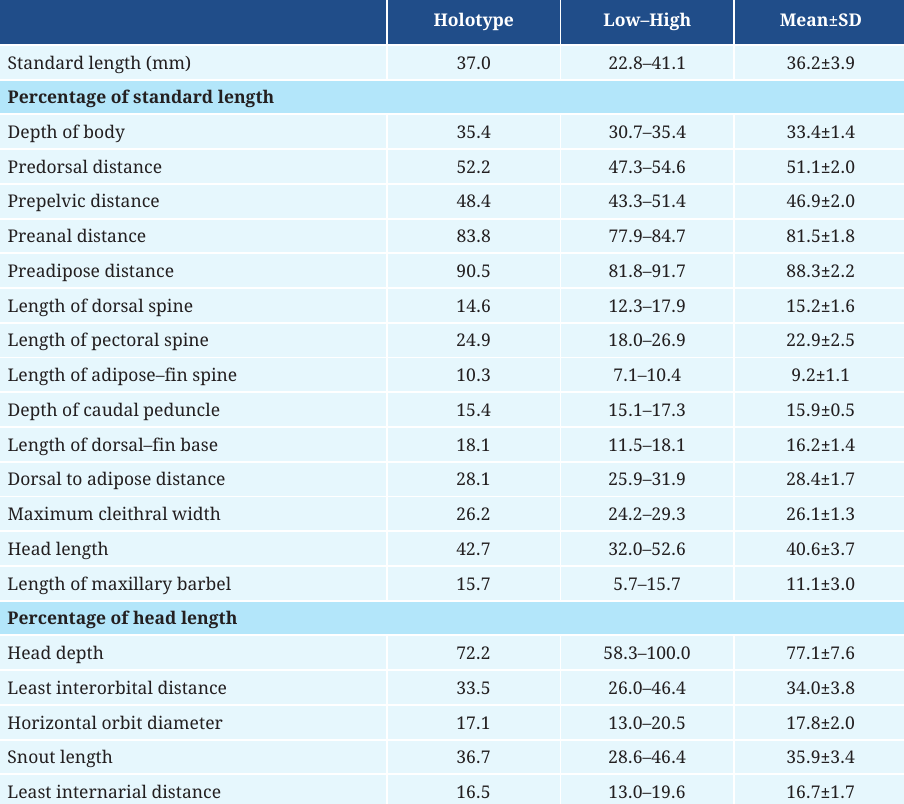
TABLE 1 | Morphometric data of the holotype and 19 paratypes of Corydoras maclurei . SD = Standard